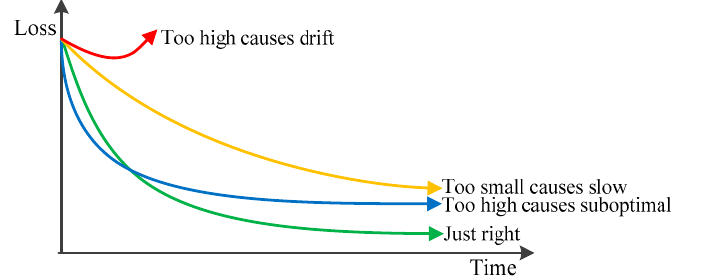
Figure 4. The tracking effect of different learning rates.